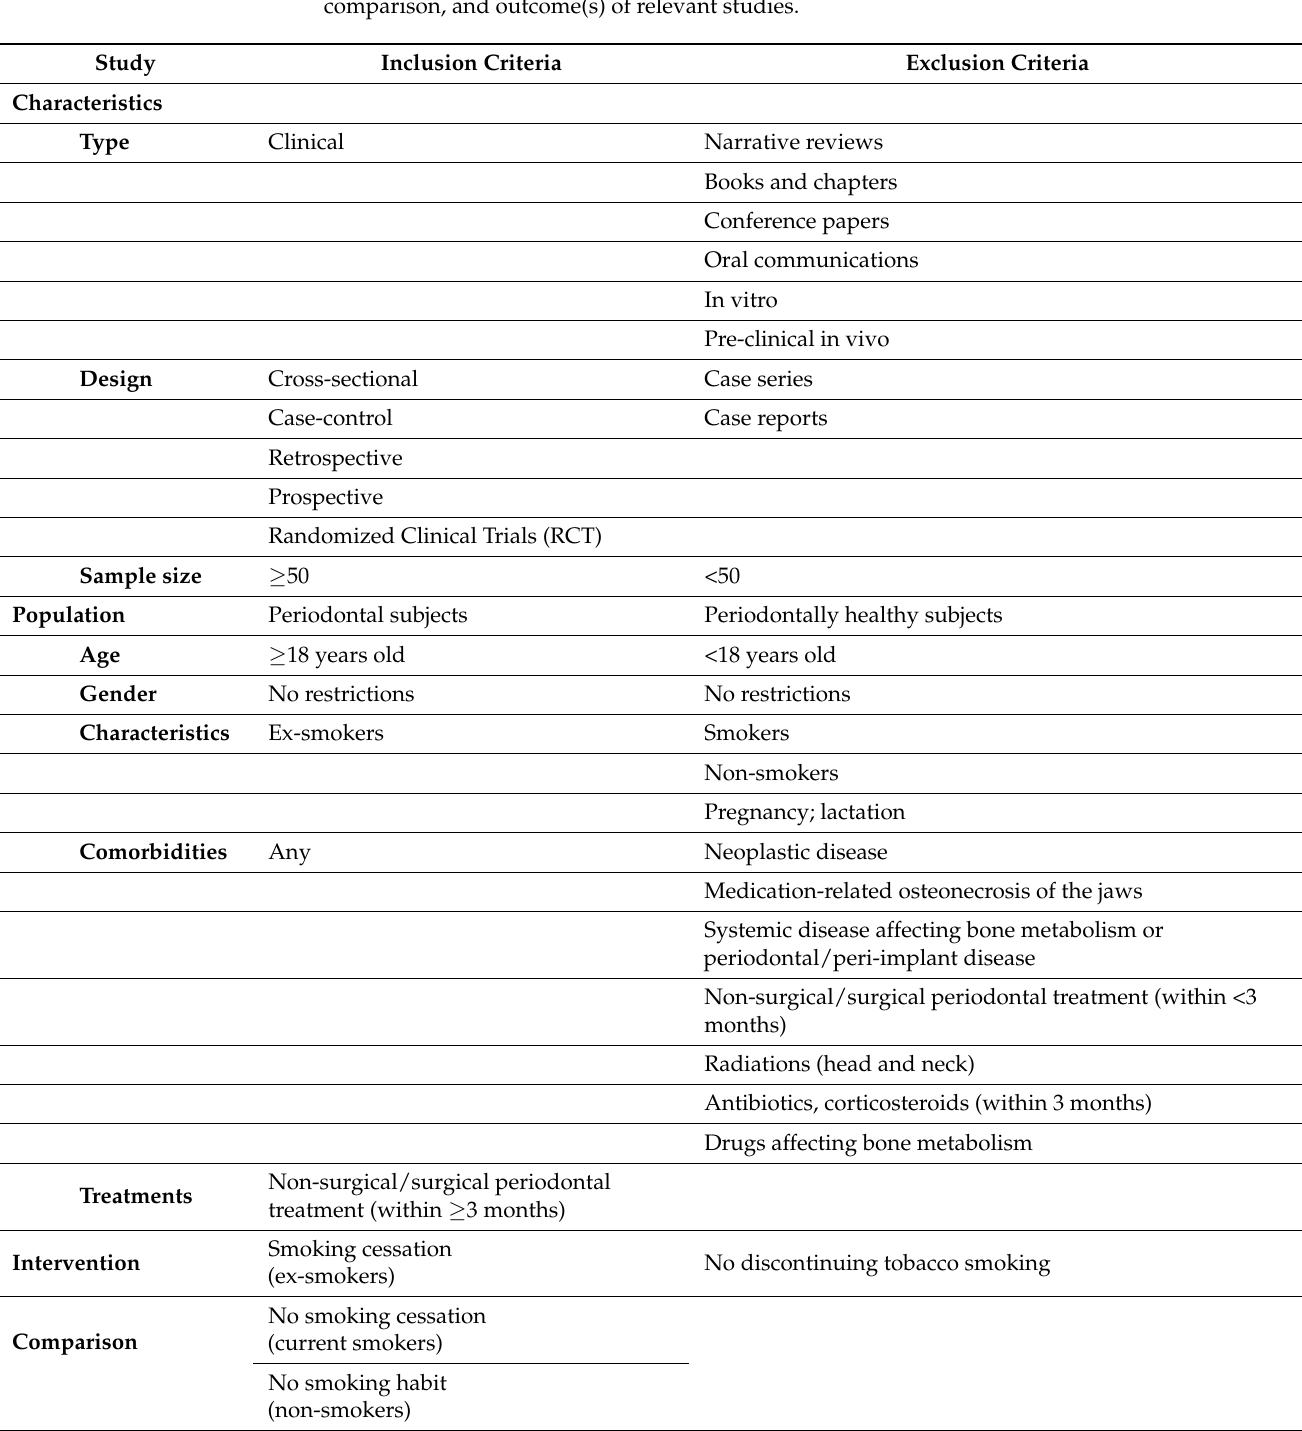
Table 1. Inclusion and exclusion criteria related to source, characteristics, population, intervention, comparison, and outcome(s) of relevant